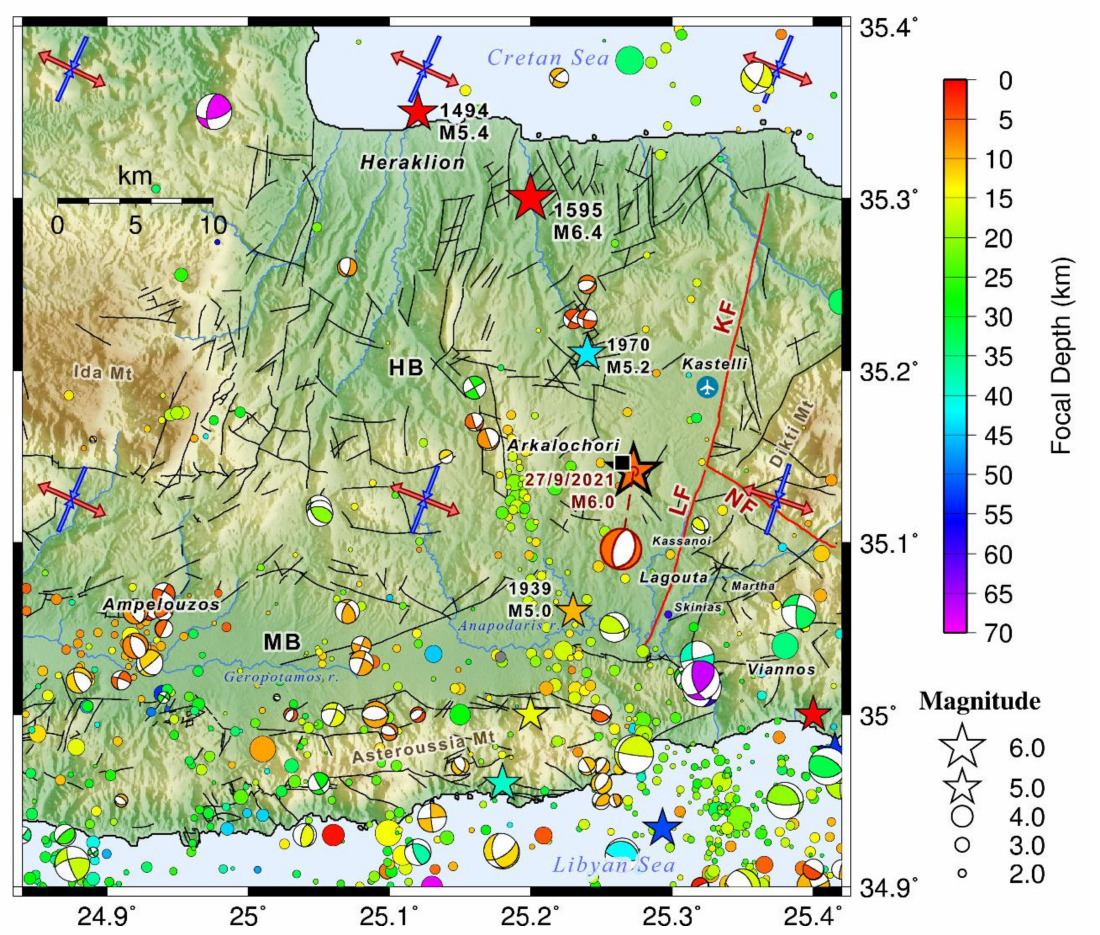
Figure 2. Close up of the study area, marked with a red rectangle in Figure 1b. Black lines show the mapped tectonic structures. Seismicity of the period from 2008 to May 2021 is from GI-NOA. The Arkalochori earthquake is represented by a star with bold outline. Note the offset beachball linked with a dashed callout line representing its focal mechanism solution from GI-NOA (see Table S1 at Supplementary Materials) and the faults, described in this work, are drawn in red (KF: Kastelli Fault, NF: Nipiditos Fault, LF: Lagouta Fault). Additional focal mechanisms are from